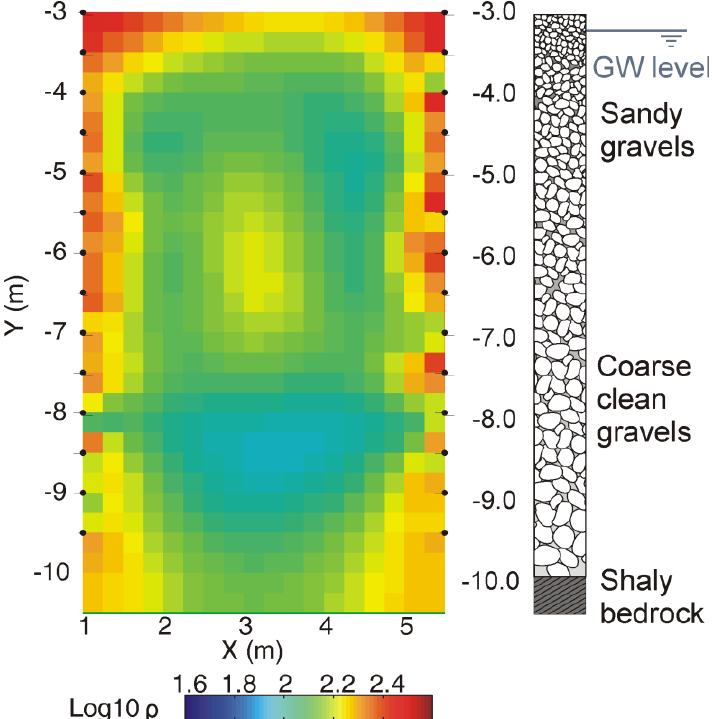
Figure 2. Background tomography obtained using 28 electrodes in two boreholes. The inverse model shows resistivity values varying between 100 and 200 Ω·m. The panel seems slightly heterogeneous and reflects lithological changes. Dots show the position of borehole electrodes. Average groundwater temperature is around 13 °C (modified after